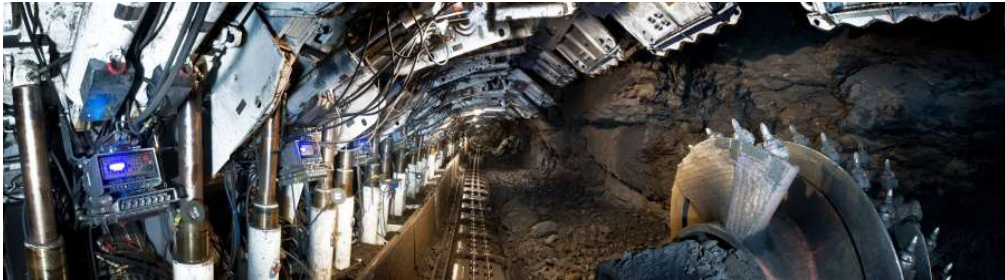
Figure 1. Typical VMM longwall face equipment.